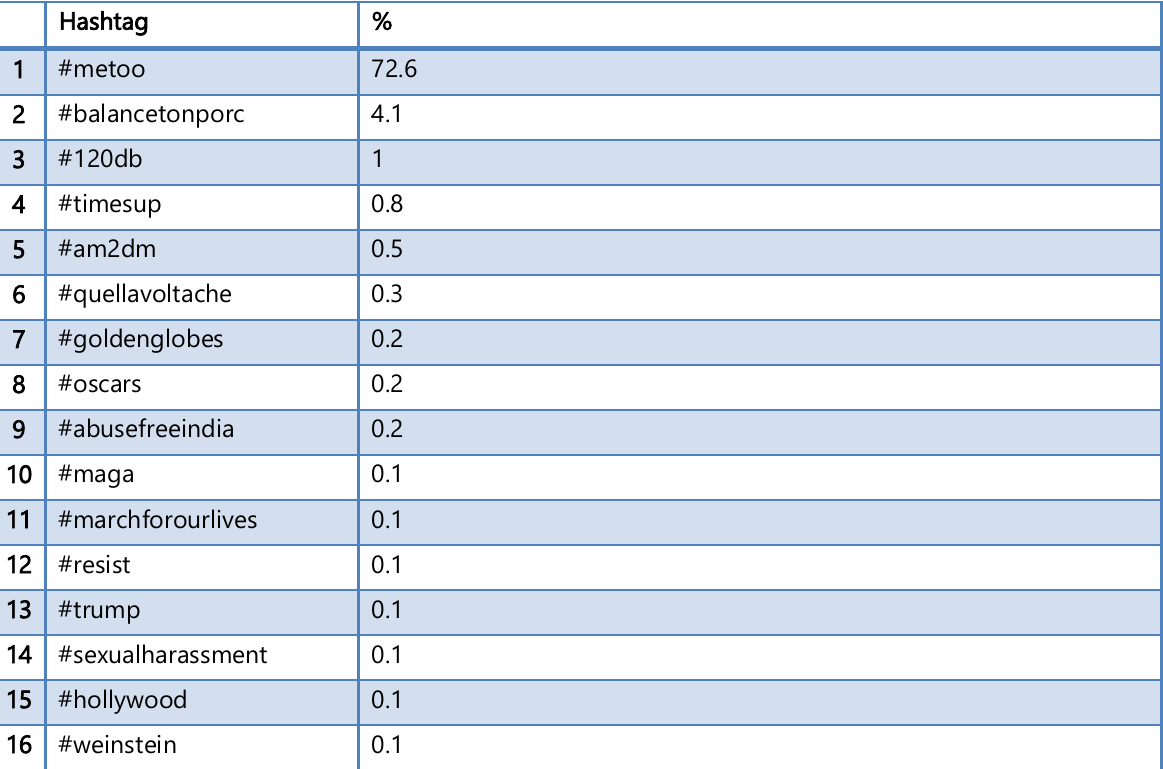
Table 3: Most Used Hashtags in the Dataset (Source: Authors‘ depiction)